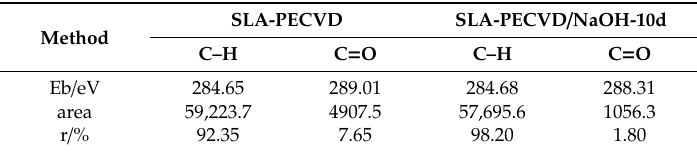
Binding energy, area, and proportion of the C1 s peaks for the SLA-PECVD and SLA-PECVD / NaOH-10d